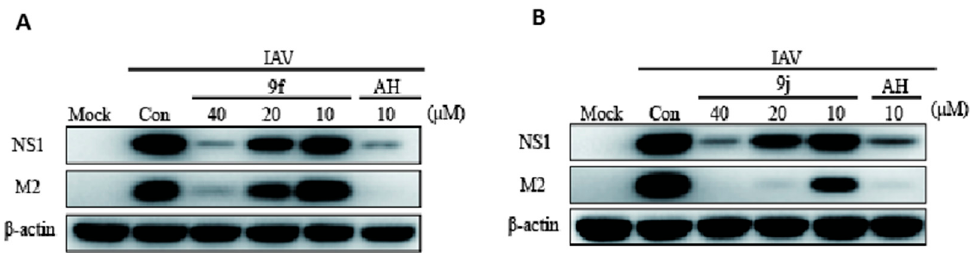
Figure 2. Compounds 9f and 9j exerted anti-H3N2 activities at the protein level. ( A and B ), MDCK cells were infected with IAV (H3N2, multiplicity of infection (MOI ) = 0.003) in the presence or absence of compound 9f and 9j in different concentrations, and AH for 24 hr. The IAV NS1 and M2 expressions were analyzed by Western blot.